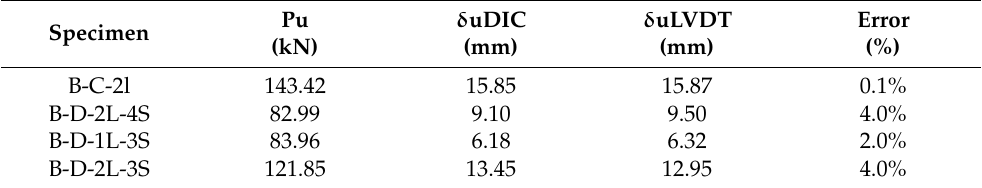
Figure 6. ( a ) B-D-2L-4S: comparison in terms of load-deflection curves; ( b ) B-C-2L: comparison in terms of load-deflection curves. Table 2. Detail of tested